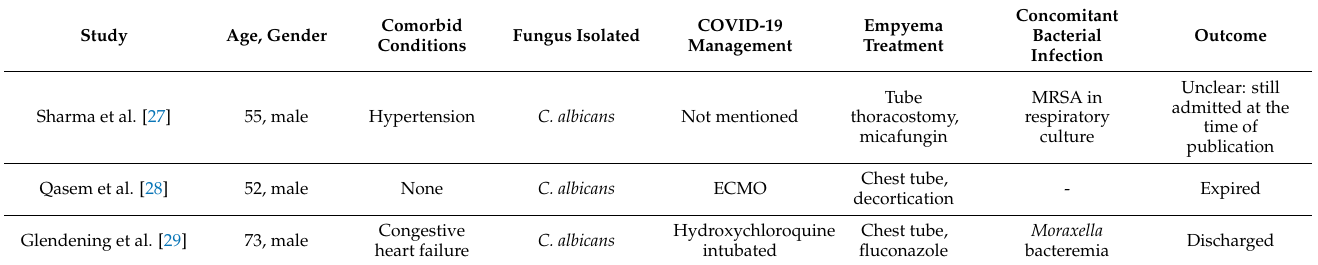
Table 2. Three prior reports of C. albicans empyemas associated with